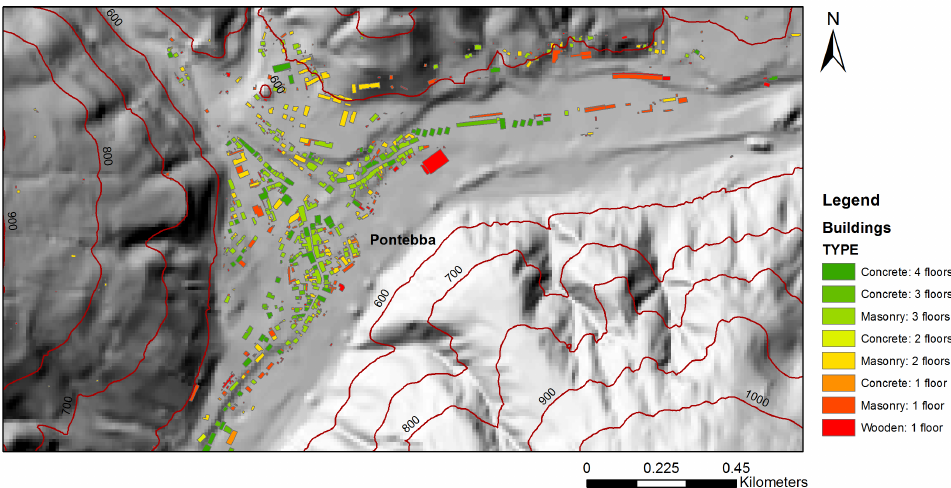
Figure 11. Classified building information in Pontebba commune, Fella River basin (Ciurean et al.,